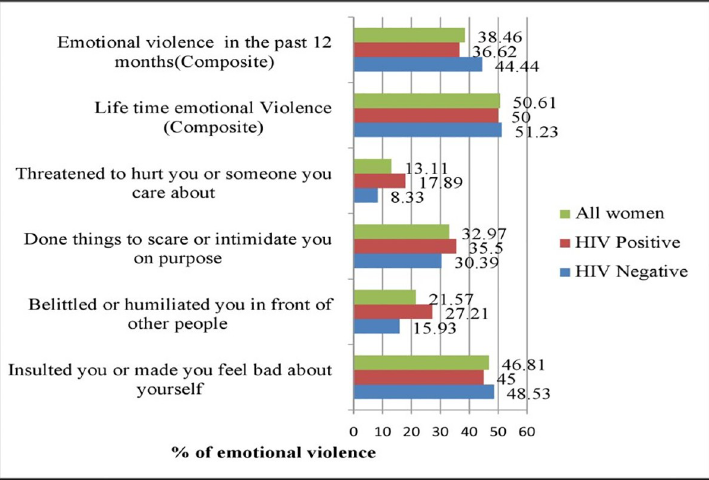
Fig 1. Emotional violence against women in Wolaita Zone, November-December